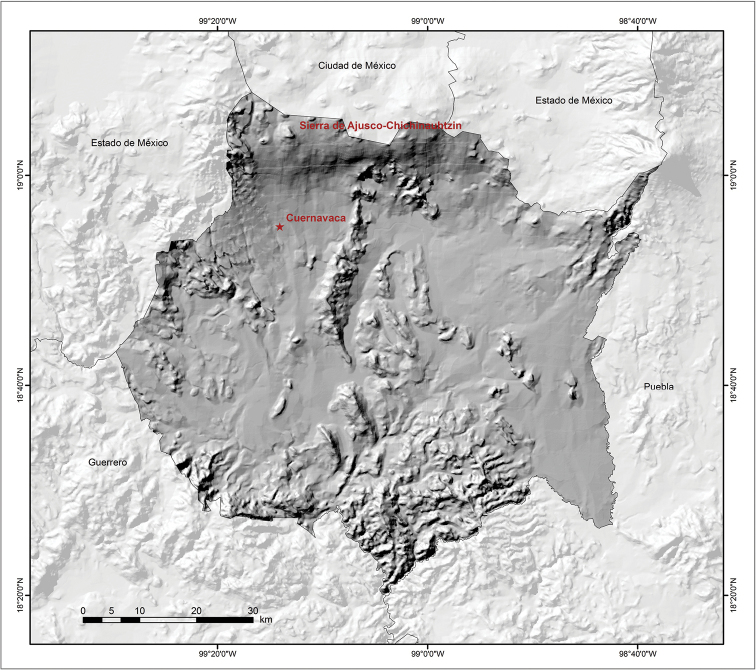
Topographical map of the state of Morelos, Mexico (INEGI 2009).